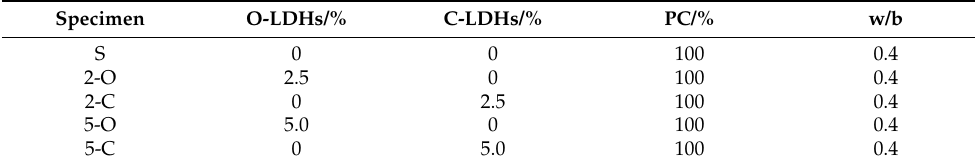
Table 3. Mixture proportions of cement paste.